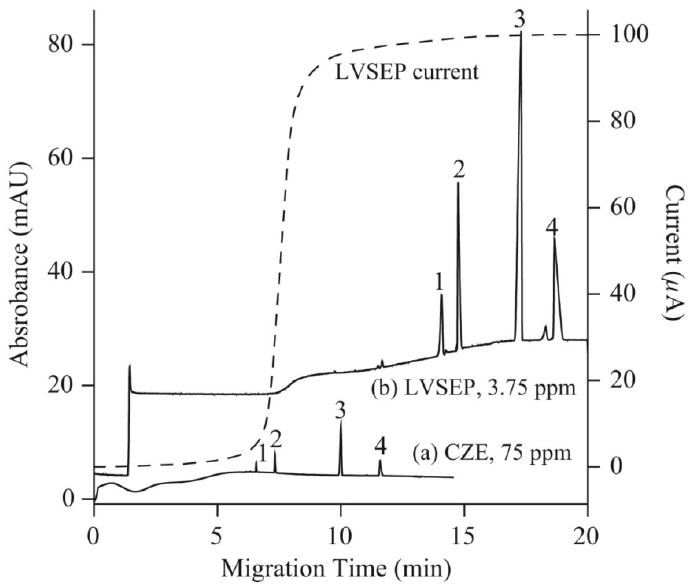
Figure 4. Electropherograms recorded for arsenic speciation using CE-UV without (a) and with large volume sample stacking with an electroosmotic flow pump (LVSEP) (b) [33]. In (a): recording for 75 ppm As of each As species (1; As(V), 2; MMA, 3; As(III), 4; DMA) in deionized water injected at 0.5 psi for 5 s, and (b): recording LVSEP of 3.75 ppm of each As species in 0.1 mM sodium phosphate buffer with full injection. CE conditions: μ SiL-FC coated capillary—60 (50) cm, 50 μ m I.D., BGE—100 mM sodium phosphate at pH 9.6, V: 20 kV, UV detection at 200 nm. Dotted line: